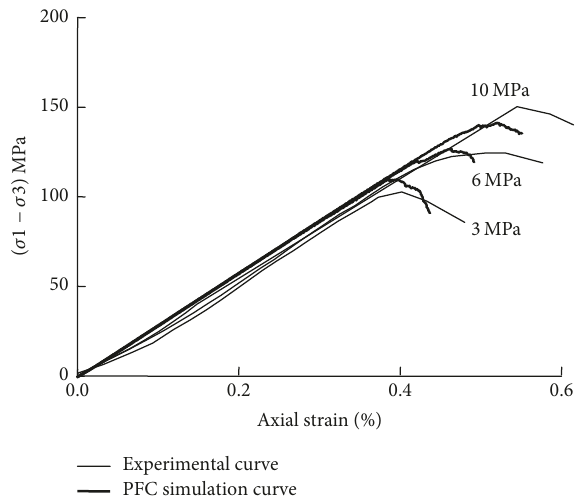
Figure 3: Failure mode of granite in compression at a confining stress of 6